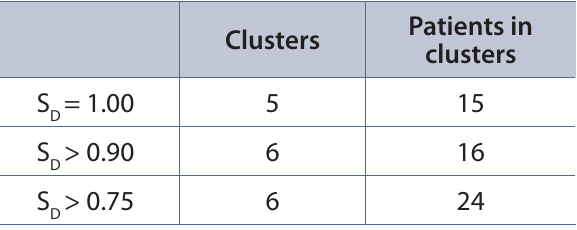
Table 2. Clusters generated with three different cut- points for Dice similarity index (clusters grouping only isolates from the same patient were excluded) Patients in Clusters clusters S = 1.00 5 D S > D